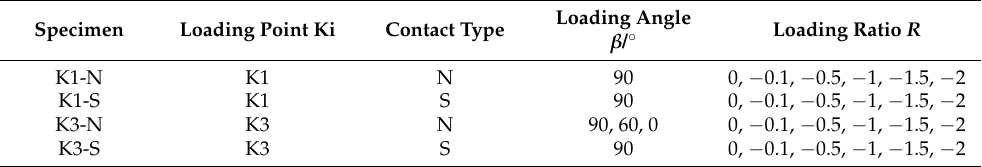
Table 1. Summary of specimen type and loading